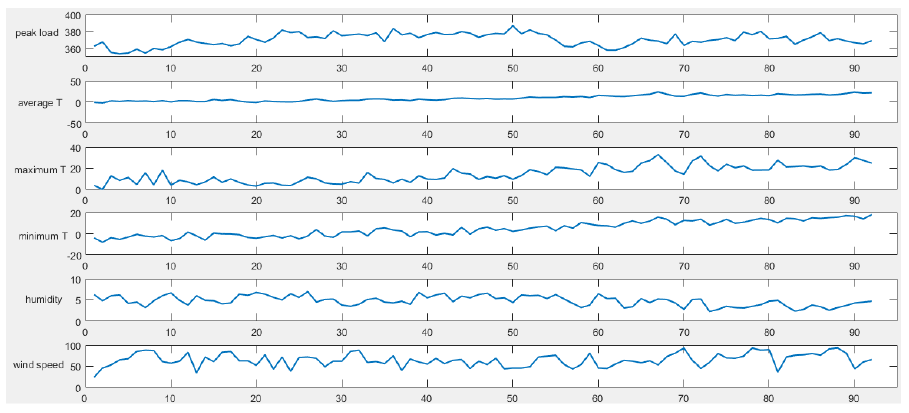
Figure 4. The collected data.